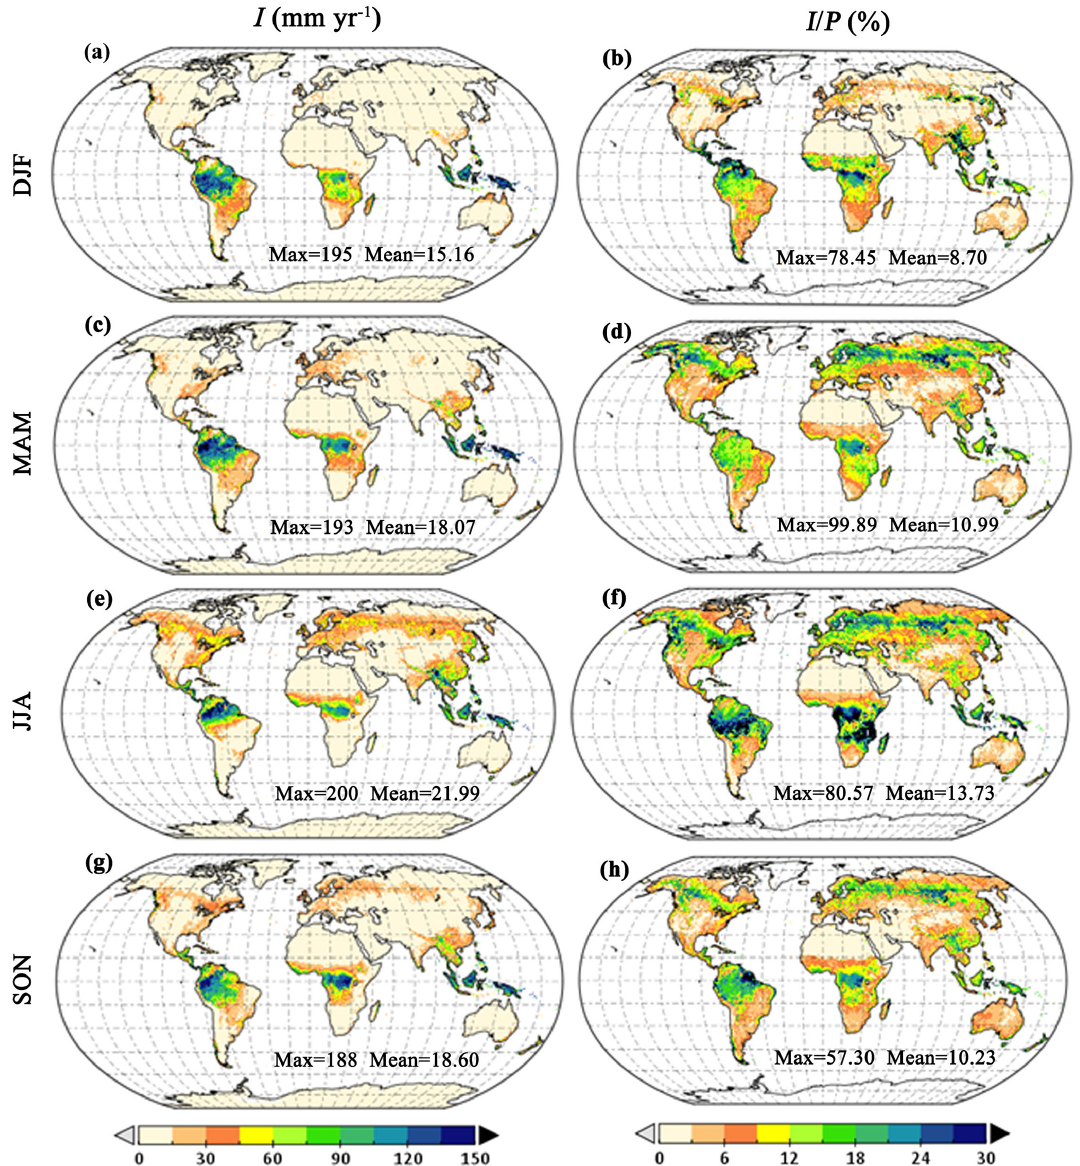
Figure 6. Global I seasonal distribution. (a,b) December–February (DJF), (c,d) March–May (MAM), (e,f) June–August (JJA) and (g,h) September–November